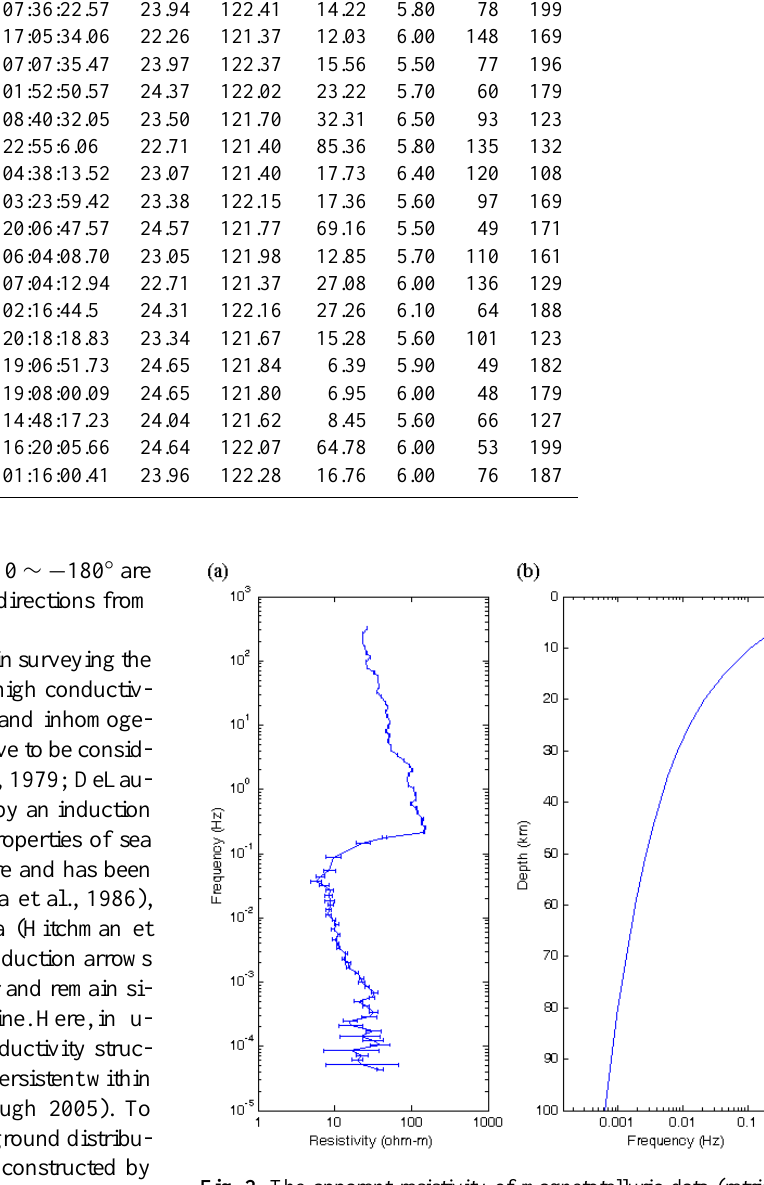
Fig. 2. The apparent resistivity of magnetotelluric data (retrieved from Chiang et al., 2010) close to the CCU station (a) and the depth to frequency section (b)